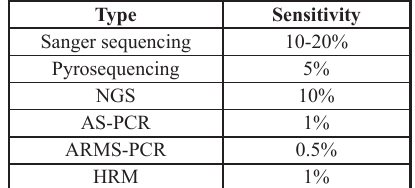
Table 2. Comparation of sensitivity of technologies for mutation detection.